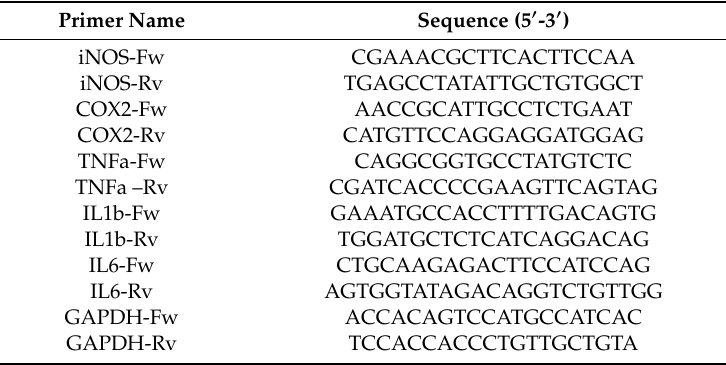
Table 1. qPCR primers